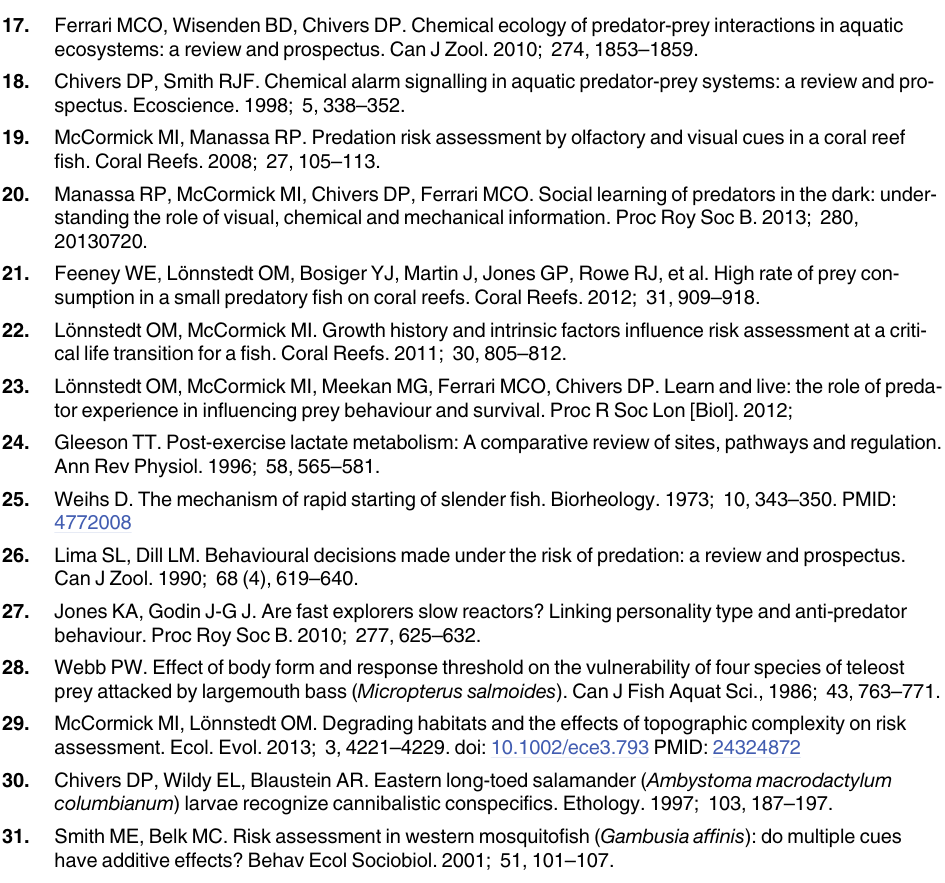
PLOS ONE | DOI:10.1371/journal.pone.0132790 August 5,